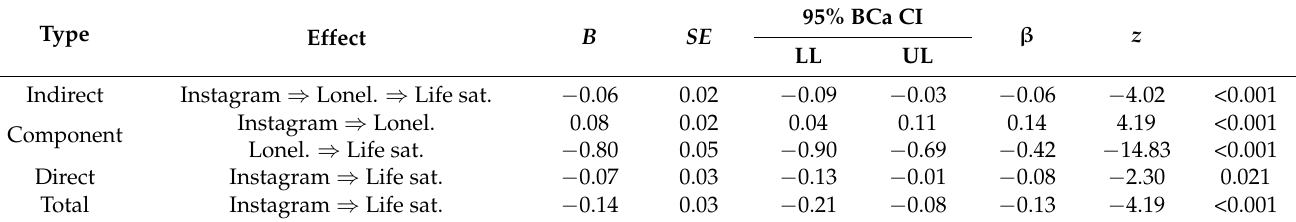
Table 3. Path Model 1 for the simple mediating effect of loneliness on the relationship between Instagram addiction and life satisfaction among university students ( N =